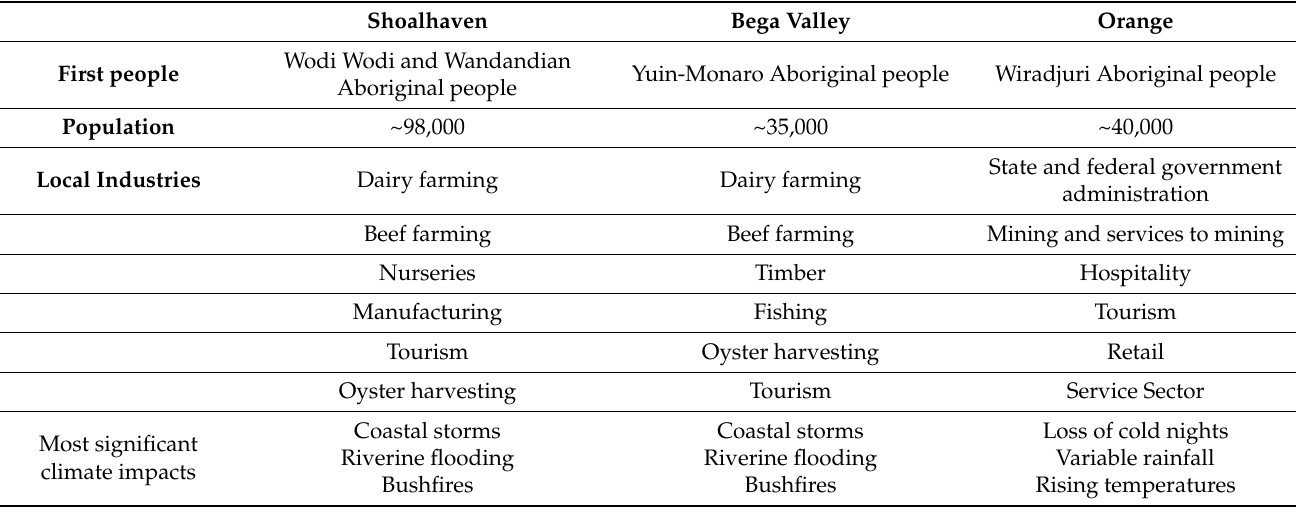
Table 1. Overview of each region.